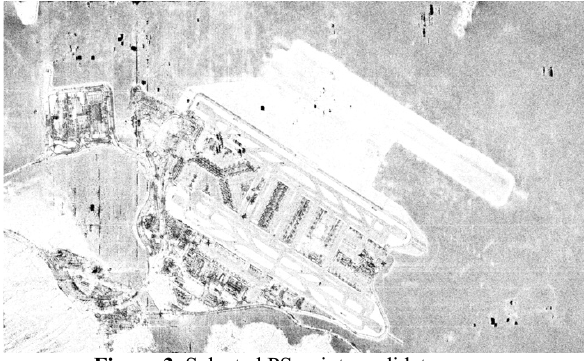
Figure 3 . Selected PS point candidates map.